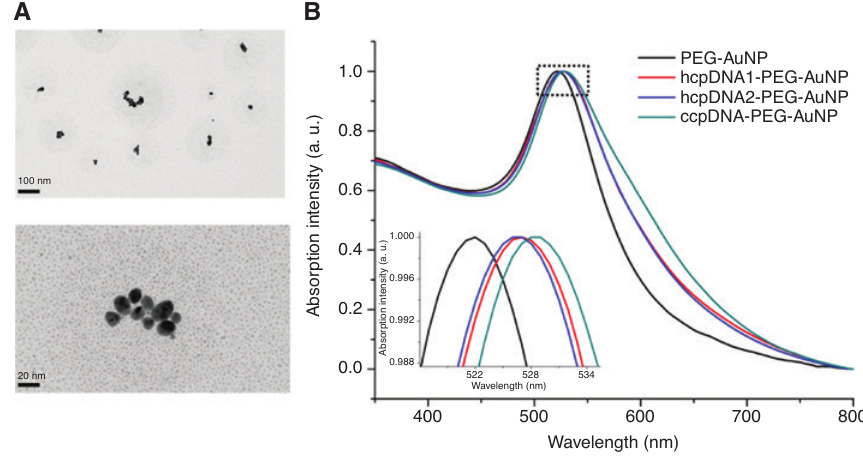
Figure 2: Characterization of AuNPs. (A) The TEM images of the PEG-AuNP. (B) The UV-Visible absorbance spectra of the PEG-AuNPs (Black), the hcpDNA1-PEG-AuNPs (Red), the hcpDNA2-PEG-AuNPs (Blue), the ccpDNA-PEG-AuNPs (Green) and the mixture of the hcpDNA1-PEG-AuNPs and hcpDNA2-PEG-AuNPs